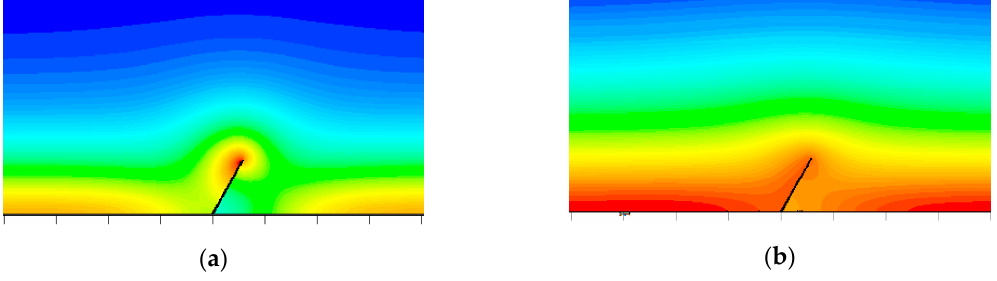
Figure 29. Temperature distribution after 0.1 s ( a ) and 1 s. ( b ) Heating pulse for the same scenario as in Figure 28.